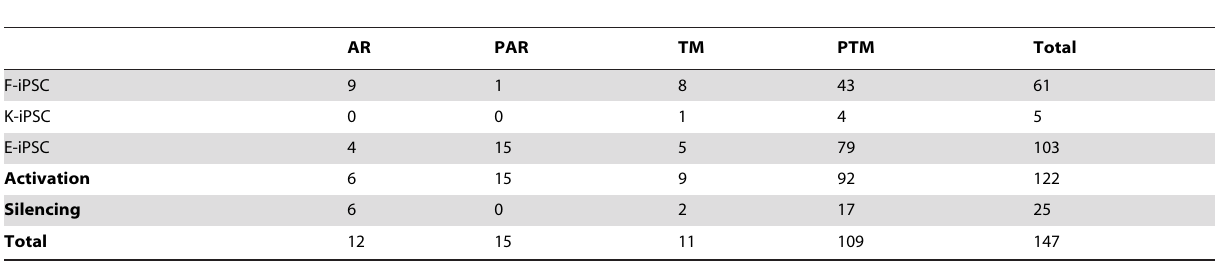
Table 1. Numbers of significantly (FDR%) differentially expressed genes in each differential expression